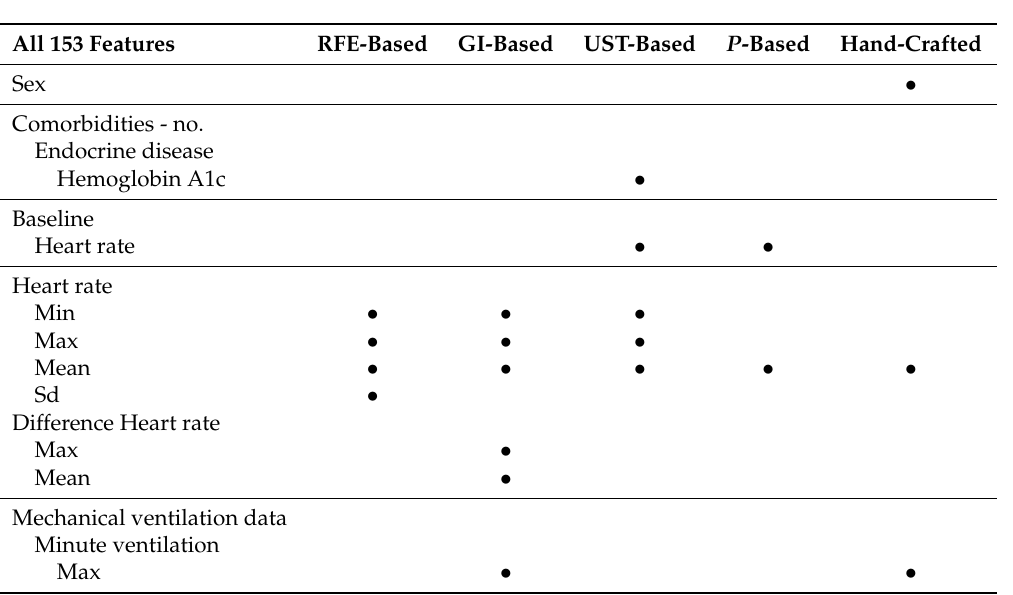
Table 2. Feature